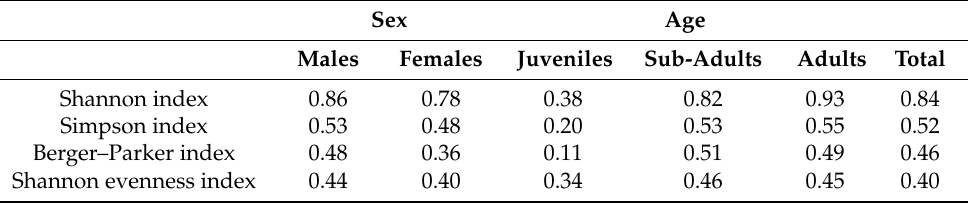
Table 9. Diversity characteristics of the helminth community of Microtus lusitanicus from Asturias by host sex and